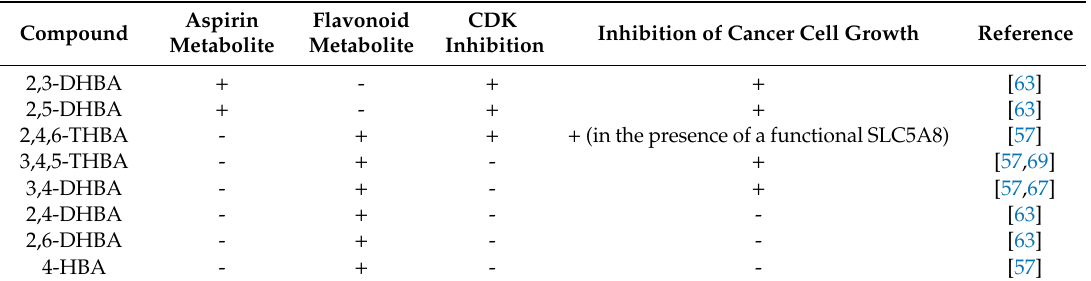
Table 1. Table showing the source of the hydroxybenzoic acid (HBA) metabolites, their potential to inhibit Cyclin Dependent Kinase (CDKs) and their ability to retard cancer cell